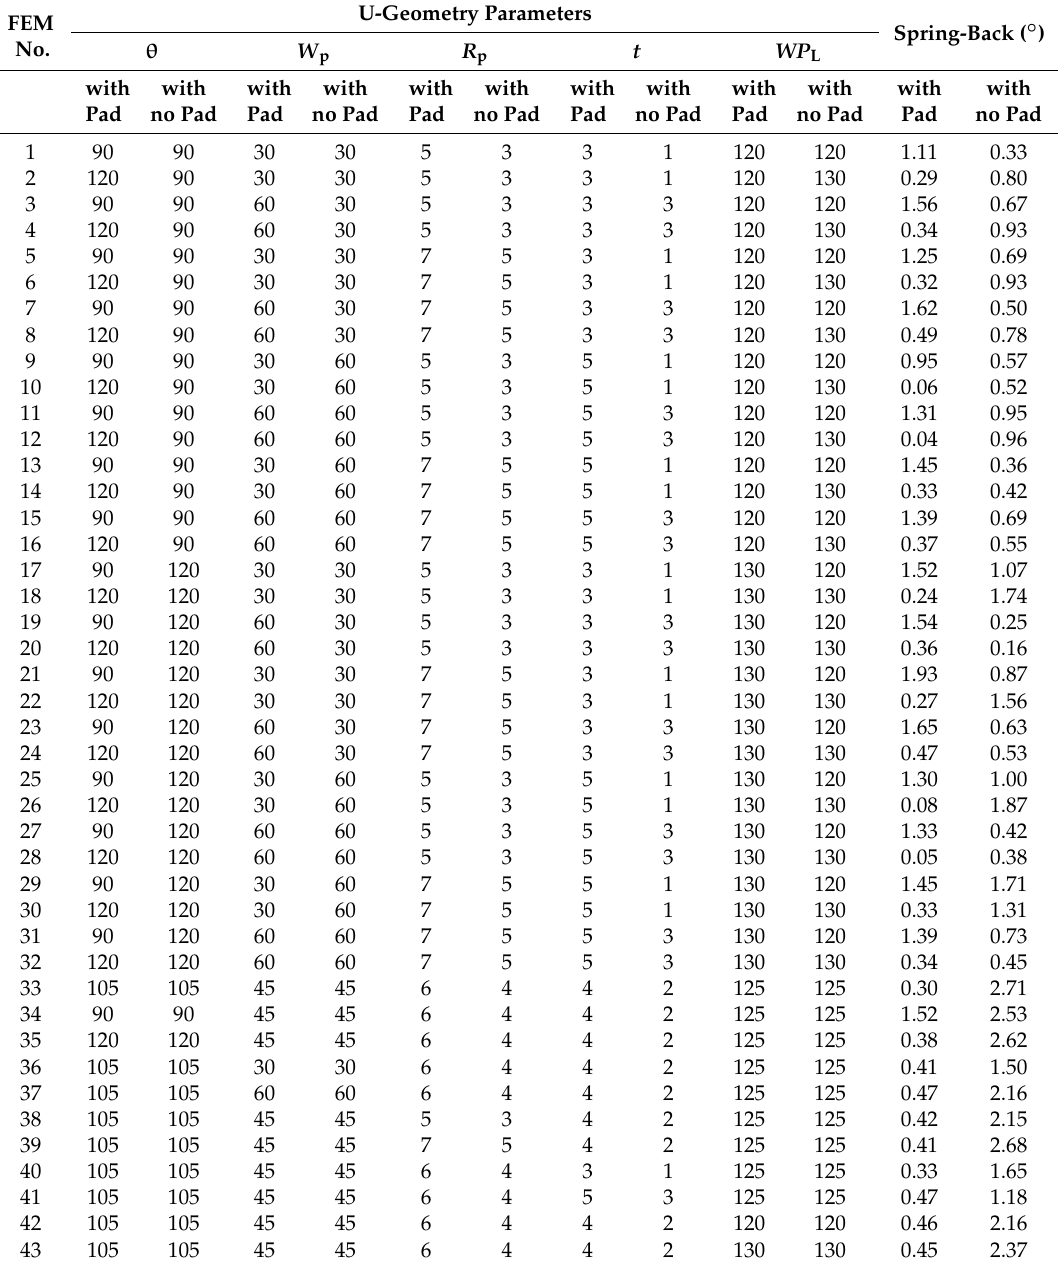
Table 3. The amounts of spring-back in cases where pressure pads and no pressure pads were used, analyzed using FEM